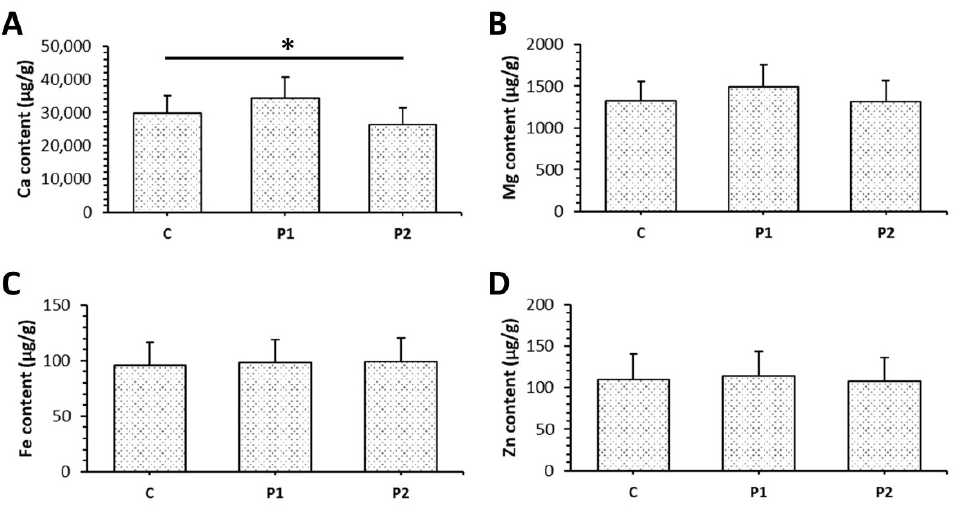
Figure 4. The content of Ca ( A ), Mg ( B ), Fe ( C ) and Zn ( D ) in femoral bones of rats from C, P1, and P2 groups. * Significant differences ( p < 0.05).